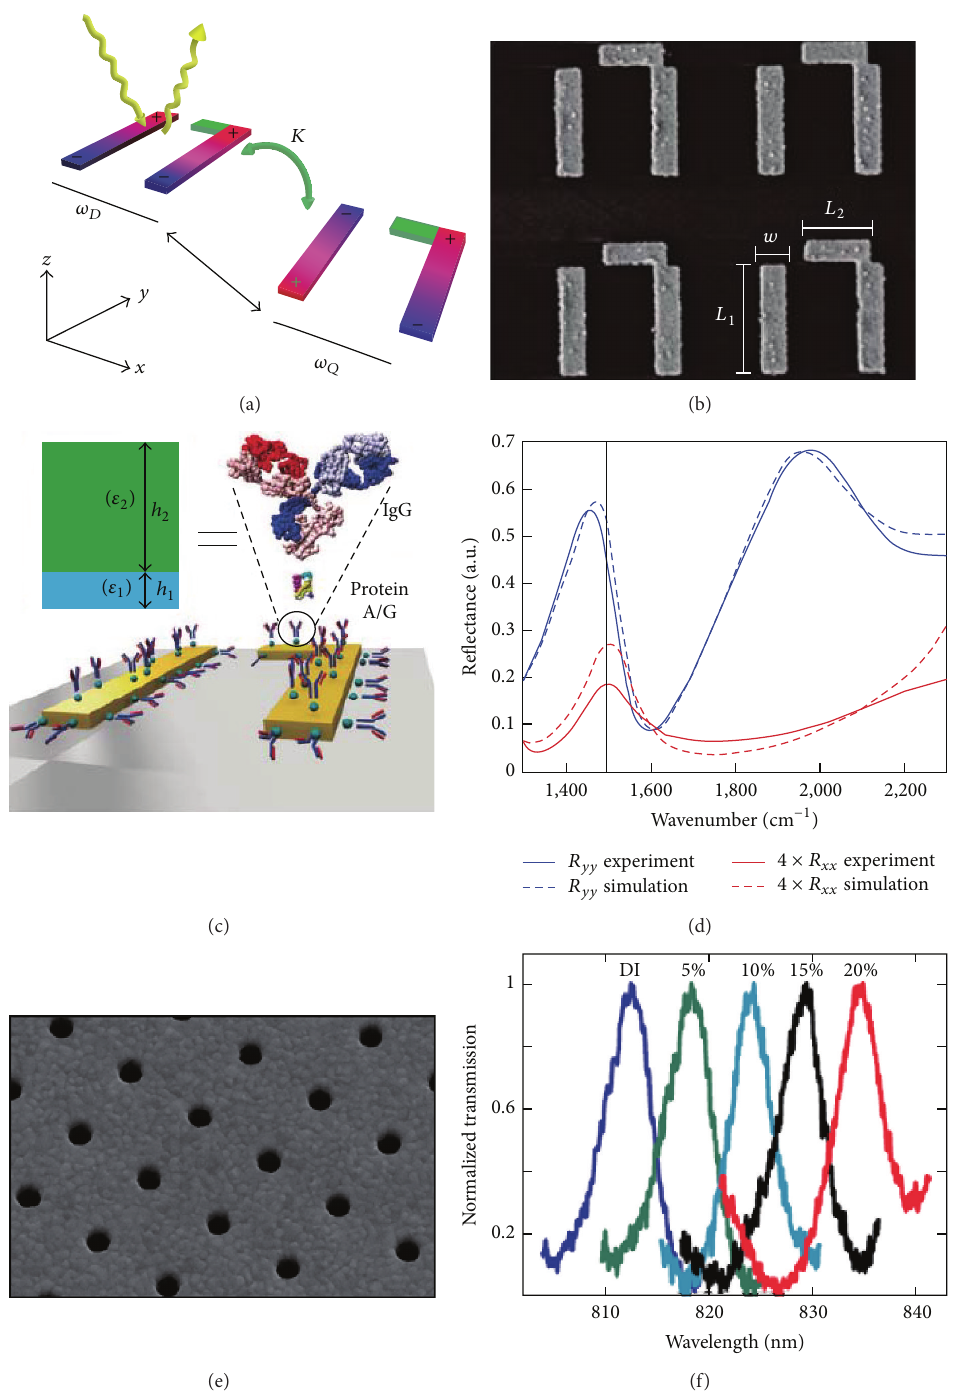
Figure 25: (a) Schematic representation of subradiant ( 𝑄 ) and superradiant ( 𝐷 ) modes. (b) Scanning electron microscopy image of a typical fabricated sample. (c) Schematic representations of proteins’ mono- and bilayers binding to the metal surface. (d) Experimental (solid) and theoretical (dashed) polarized reflectivity spectra. (e) SEM image of a fabricated metasurface consisting of hole array. (f) Resonance shift for the subradiant SPP mode with changing NaCl concentration. Figures are reproduced from (a)–(d) [144] and (e, f)